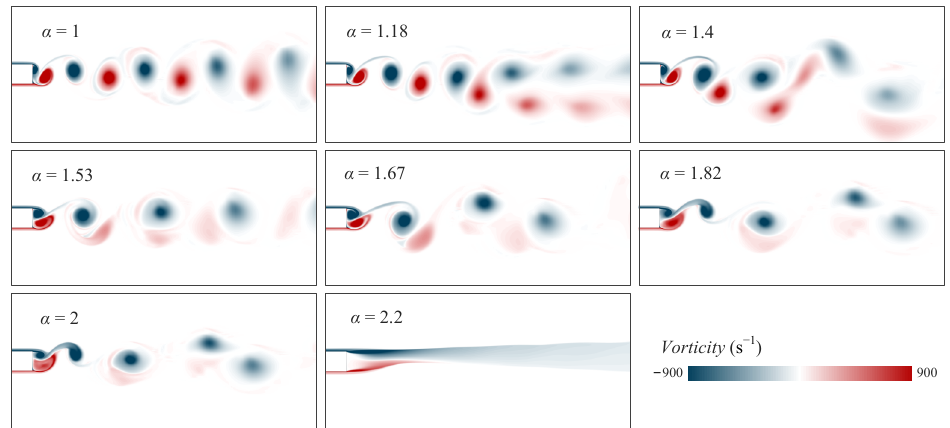
Figure 6. Vorticity contours downstream of the hydrofoil under different α.